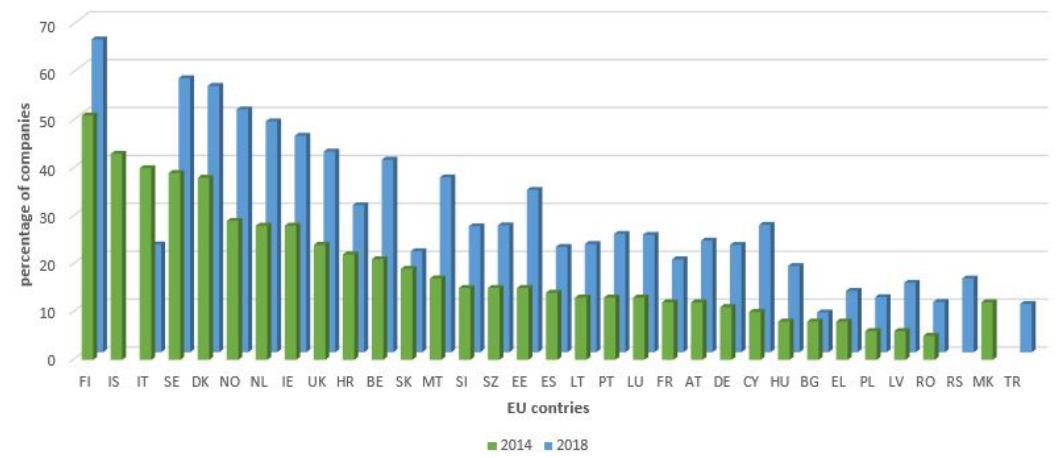
Figure 3. Use of cloud services in the EU countries for the year 2018 vs. year 2014 expressed in the percentage of companies (the data used for generating the graph was adapted from